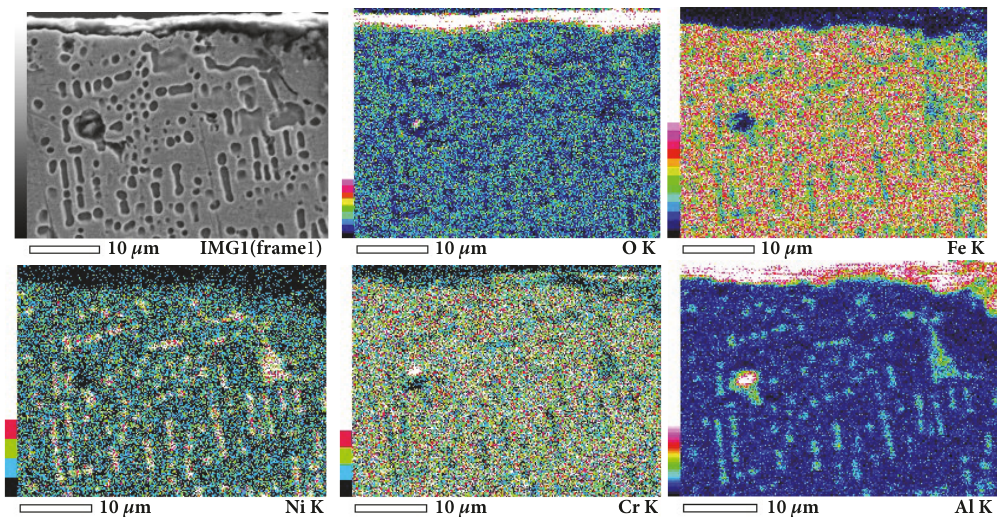
Figure 8: X-ray mapping of scale on sample oxidized at 900 ∘ C for 150 hrs.